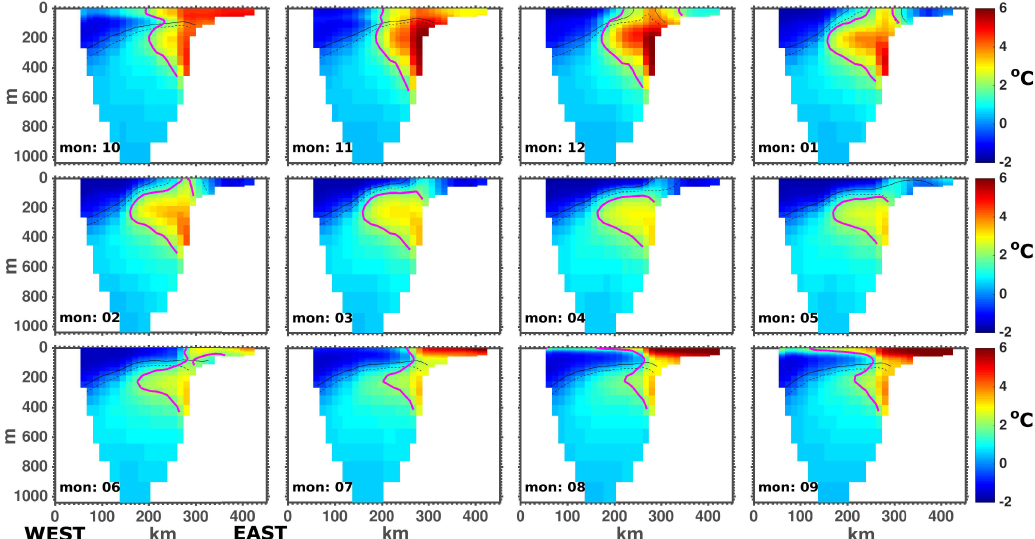
Figure 5. The monthly average temperature through the period of 2004 to 2010 at Davis Strait from LowResControl. The magenta line represents the 2 ◦ C isotherm, the black line is the 34 . 0 salinity isohaline, and the dashed black line is the 34 . 2 salinity isohaline.